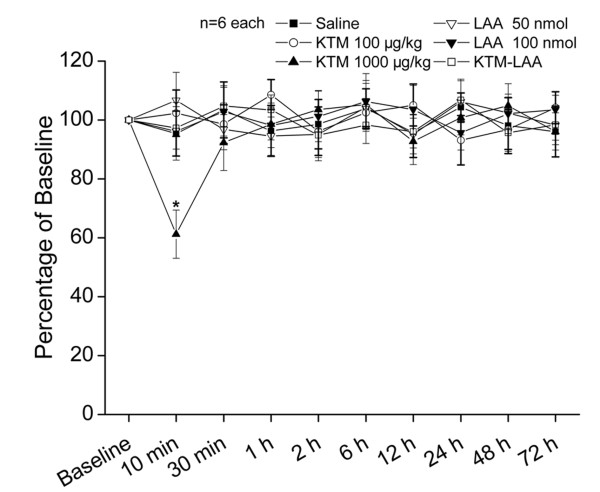
Effects of ketamine and/or LAA on rats' motor performance in rotarod test. Immediately after a baseline response was obtained, saline or drugs were administered intrathecally to normal rats and rotarod test was performed at different time points thereafter (6 rats in each group). The score of each group was normalized as a percentage of the baseline value. Compared with baseline, there was no statistical difference obtained from rotarod test after drugs injection, but intrathecally administered 1000 μg/kg of ketamine caused an obvious defect on rotarod test at 10 min after injection. * P < 0.05 compared with baseline response.